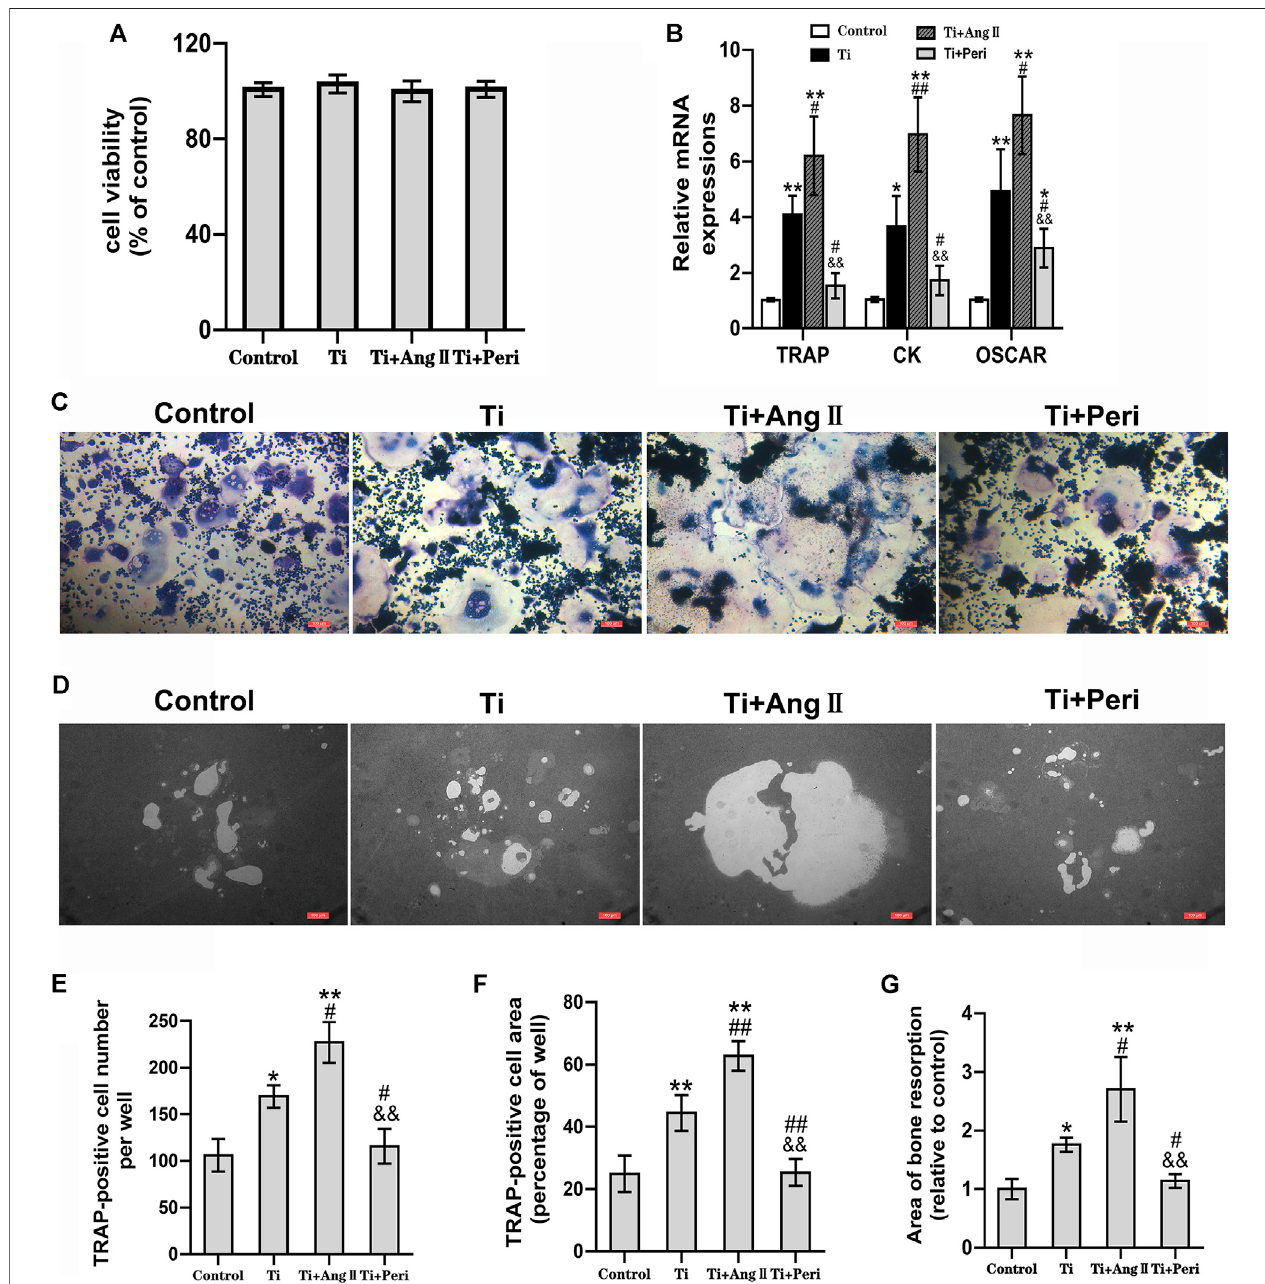
FIGURE 5 | Ang II promoted but perindopril suppressed Ti-particle-induced osteoclastogenesis, osteoclast-mediated bone resorption, and expression of osteoclast-related genes in RAW264.7 macrophages. Data are representative images or expressed as the mean ± SD of each group from three separate experiments ( n (cid:1) 3pergroup). (A) CCK8assayofcellviability48 haftertreatment. (B) RT-qPCRanalysesofrelativelevelsofosteoclast-speci fi cgenes(TRAP,CK,andOSCAR)tothe control GAPDH expression on day fi ve. (C) TRAP staining for osteoclast formation and differentiation on day seven. Representative TRAP staining images (magni fi cation × 100). (D) Representative images of bone resorption in osteo assay plates (magni fi cation × 100) on day seven. (E) The number of TRAP-positive cells per well. (F) Thearea ofTRAP-positive cellsper well. (G) The areaofresorptionper well. * p < 0.05 vs. thecontrol group; ** p < 0.01vs. thecontrol group; # p < 0.05 vs. theTi group; ## p < 0.01 vs. the Ti group; && p < 0.01 vs. the Ti + Ang II